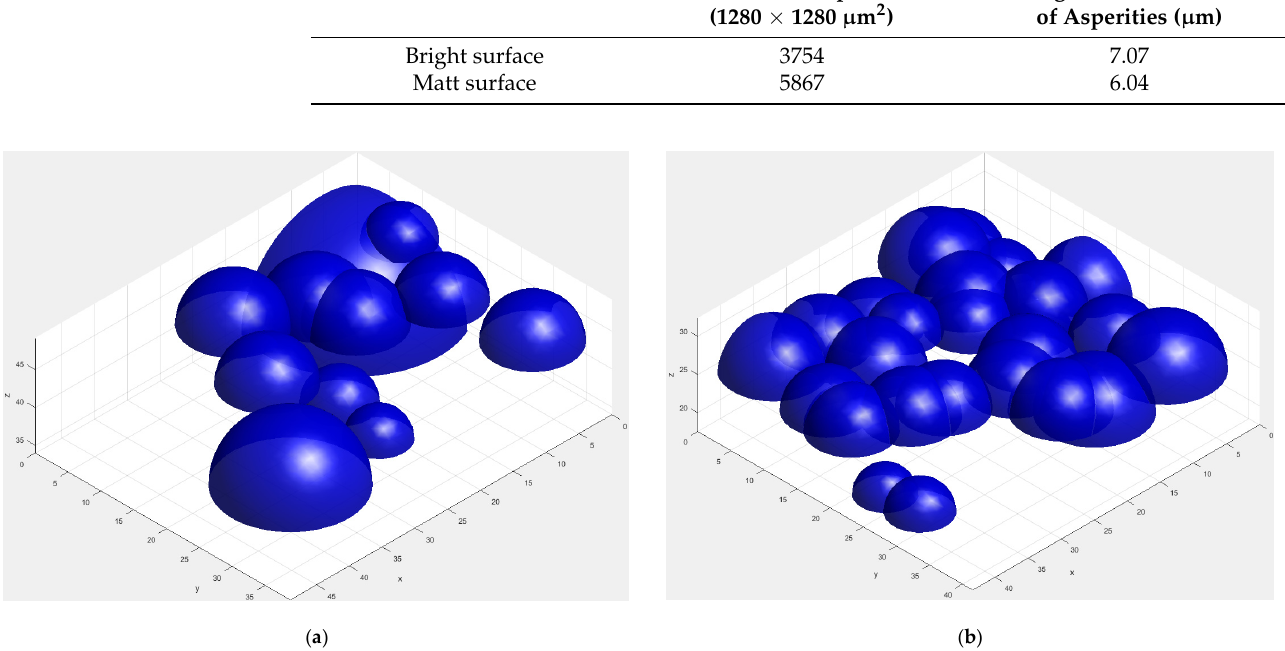
Figure 8. Three-dimensional distributions of the asperities identified with the 9PSP method. ( a ) Bright surface. ( b ) Matt surface.